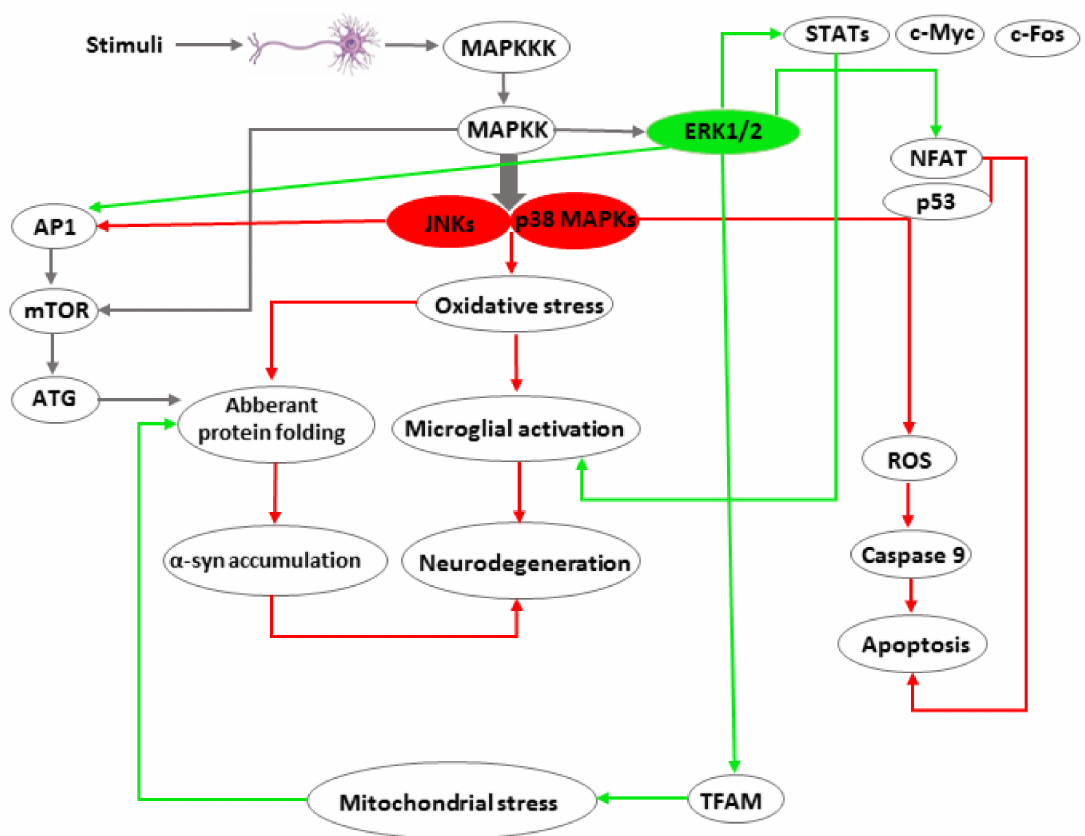
Figure 2. Involvement of MAPKs in processes that lead to Parkinson’s disease pathology. Different stimuli (stress stimuli, growth factors, cytokines, mitogens, pathogens, toxins) induce activation of MAPK pathways including activation of MAPKKK and MAPKK followed by phosphorylation of downstream targets such as JNKs, p38 MAPKs, and ERK1/2. JNKs and p38 MAPKs are grouped together due to their involvement in the “death pathway” (marked in red) while ERK1/2 is believed to promote cell growth and differentiation (marked in green). Activation of JNKs and p38 MAPKs promote oxidative stress and apoptosis, which are main contributors to PD pathogenesis. Oxidative stress may also cause microglial activation and chronic inflammation, which are toxic for brain cells and leads to PD pathology. In addition, ERK1/2 contribute to apoptosis of brain cells through the activation of NFAT and p53 and to neuronal inflammation through the activation of STATs. Both ERK1/2 and JNKs activate mTOR signaling, which promotes neurodegeneration such as that observed in